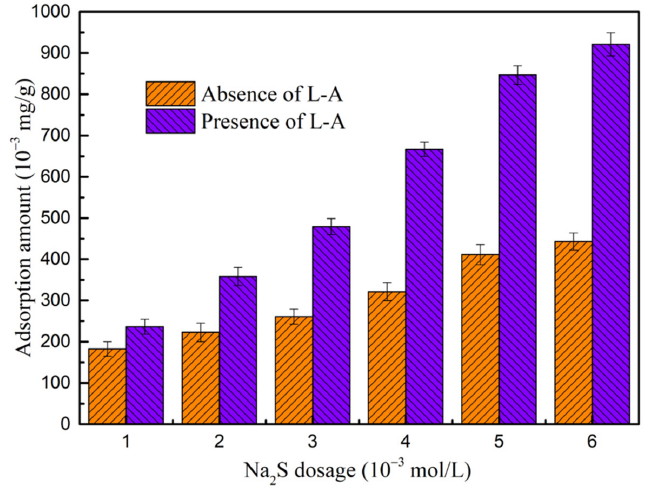
Figure 6. The adsorption amount of S in the solution as a function of Na 2 S dosage in the absence